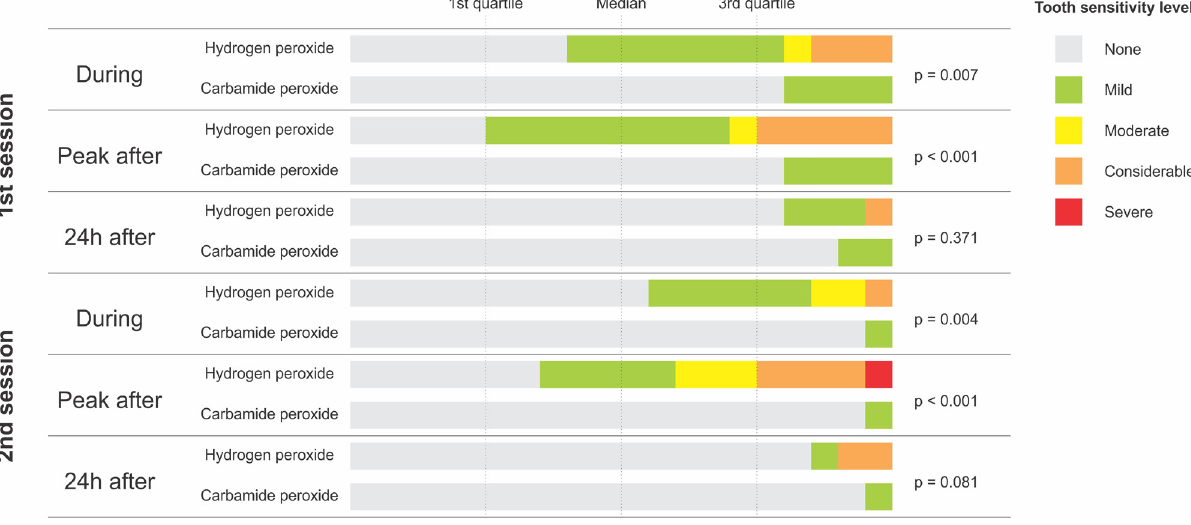
Figure 3- Distribution of the tooth sensitivity scores reported by patients using a verbal rating scale according to time of assessment and tooth bleaching protocol. * Calculated using the Mann-Whitney